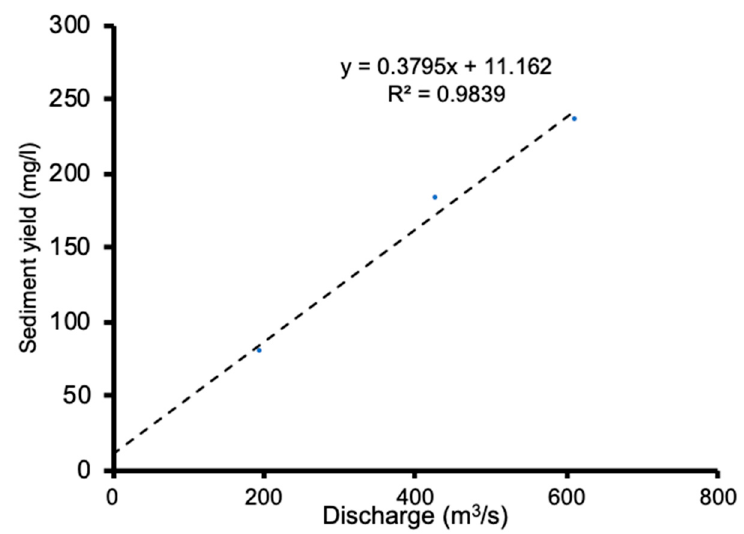
Figure 7. Relation between observed river flow and suspended sediment yield.